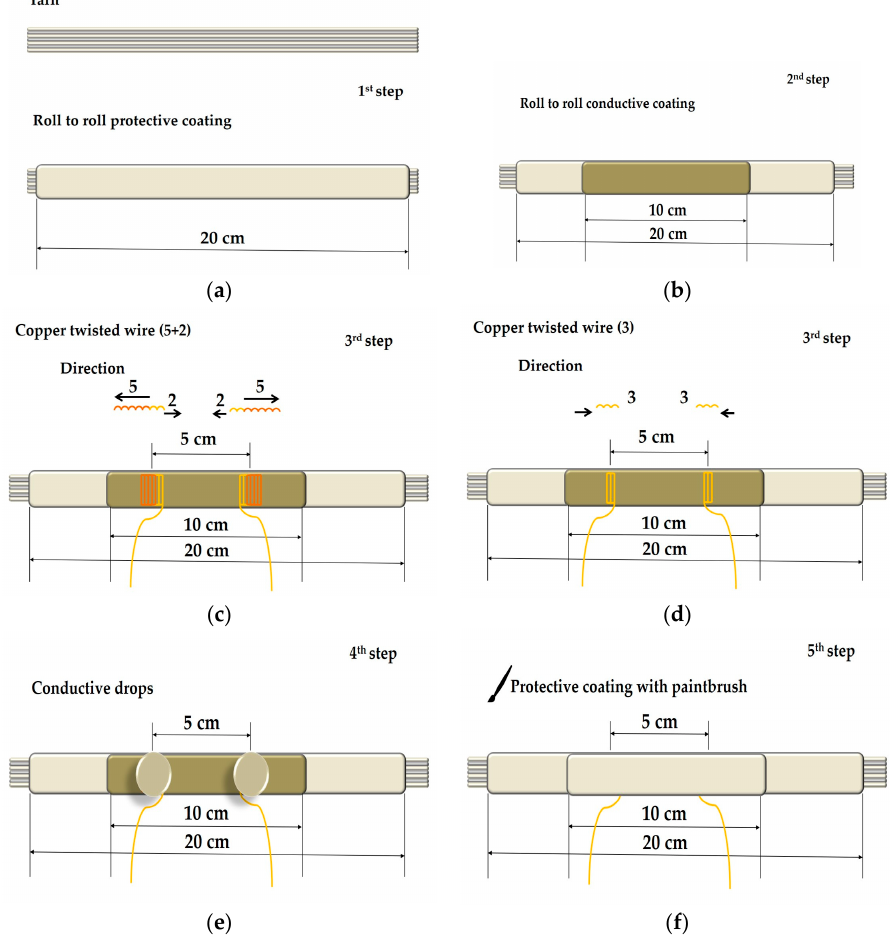
Figure A3. Production of one textile sensor—scheme: ( a ) roll to roll protective coating, ( b ) roll to roll conductive coating, ( c ) copper wire direction (5 + 2 rounds), ( d ) copper wire direction (3 rounds), ( e ) conductive drops addition, ( f ) last protective coating applied with paintbrush.